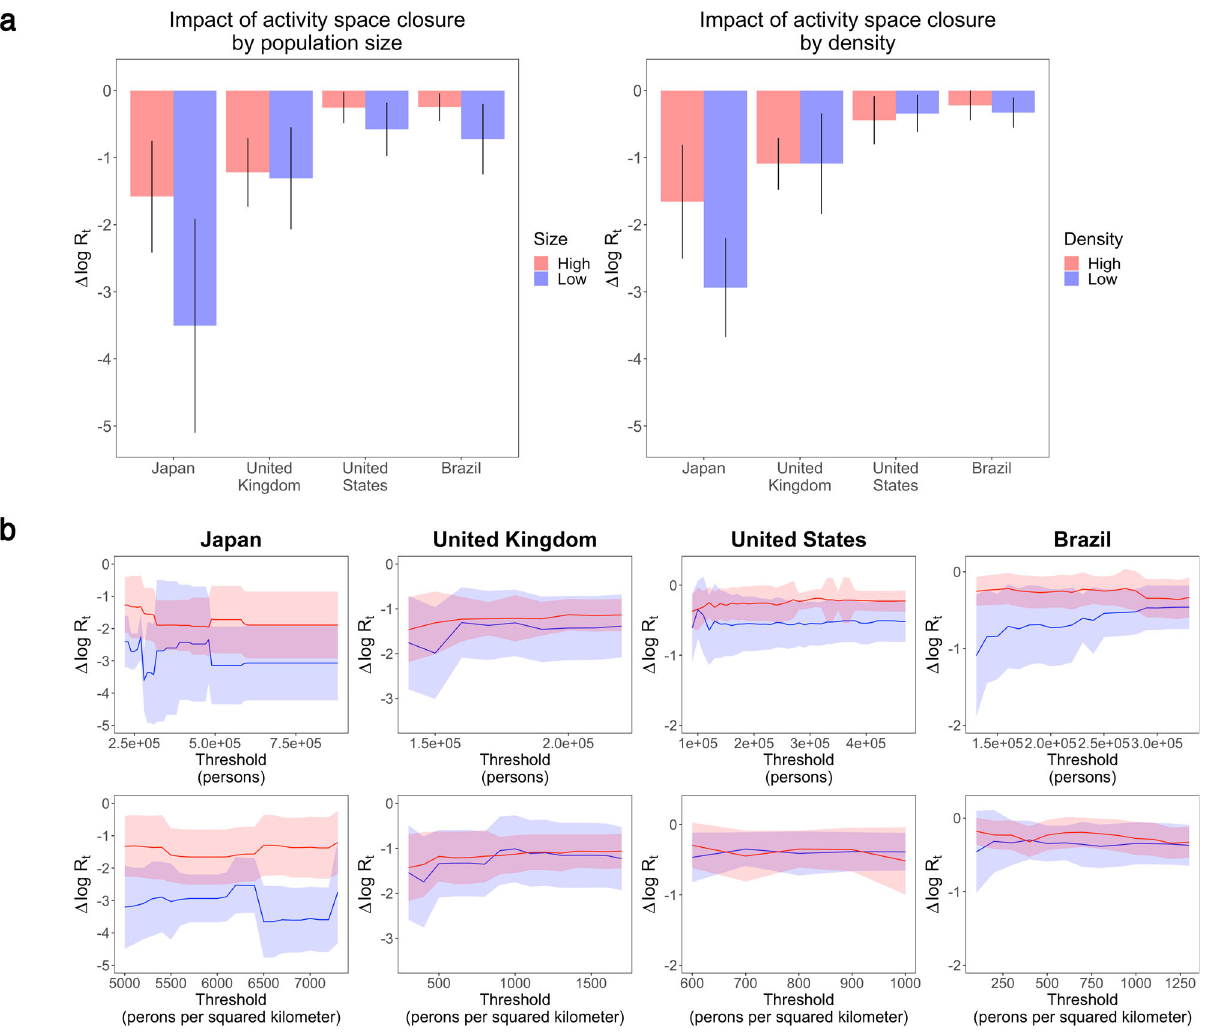
Fig. 4 Impact of establishment closures in settlements with different population size and density. a Comparison of the impacts in relatively large and small, and high and low density settlements, split by the median settlement population size and density in the sample. b Comparison of the impacts using different population size and density cut-off values. The error bars and ribbons represent 95% con fi dence